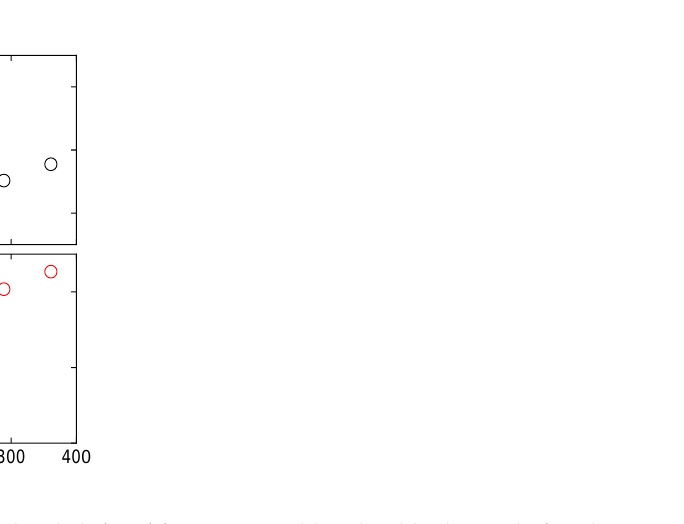
Figure 44. Overtone-normalized shifts of frequency and bandwidth obtained after depositing a polymer film with a thickness of about 500 nm onto the resonator plate. The area in green denotes values of – Δ f / n which deviate from the prediction by Equation (46). The deviations go back to flexural motion. Adapted from [80].